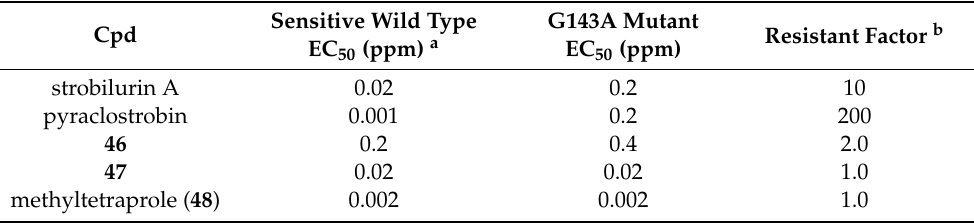
Table 6. In vitro antifungal tests against sensitive wild-type and G143A mutant of Zymoseptoria tritici from Reference